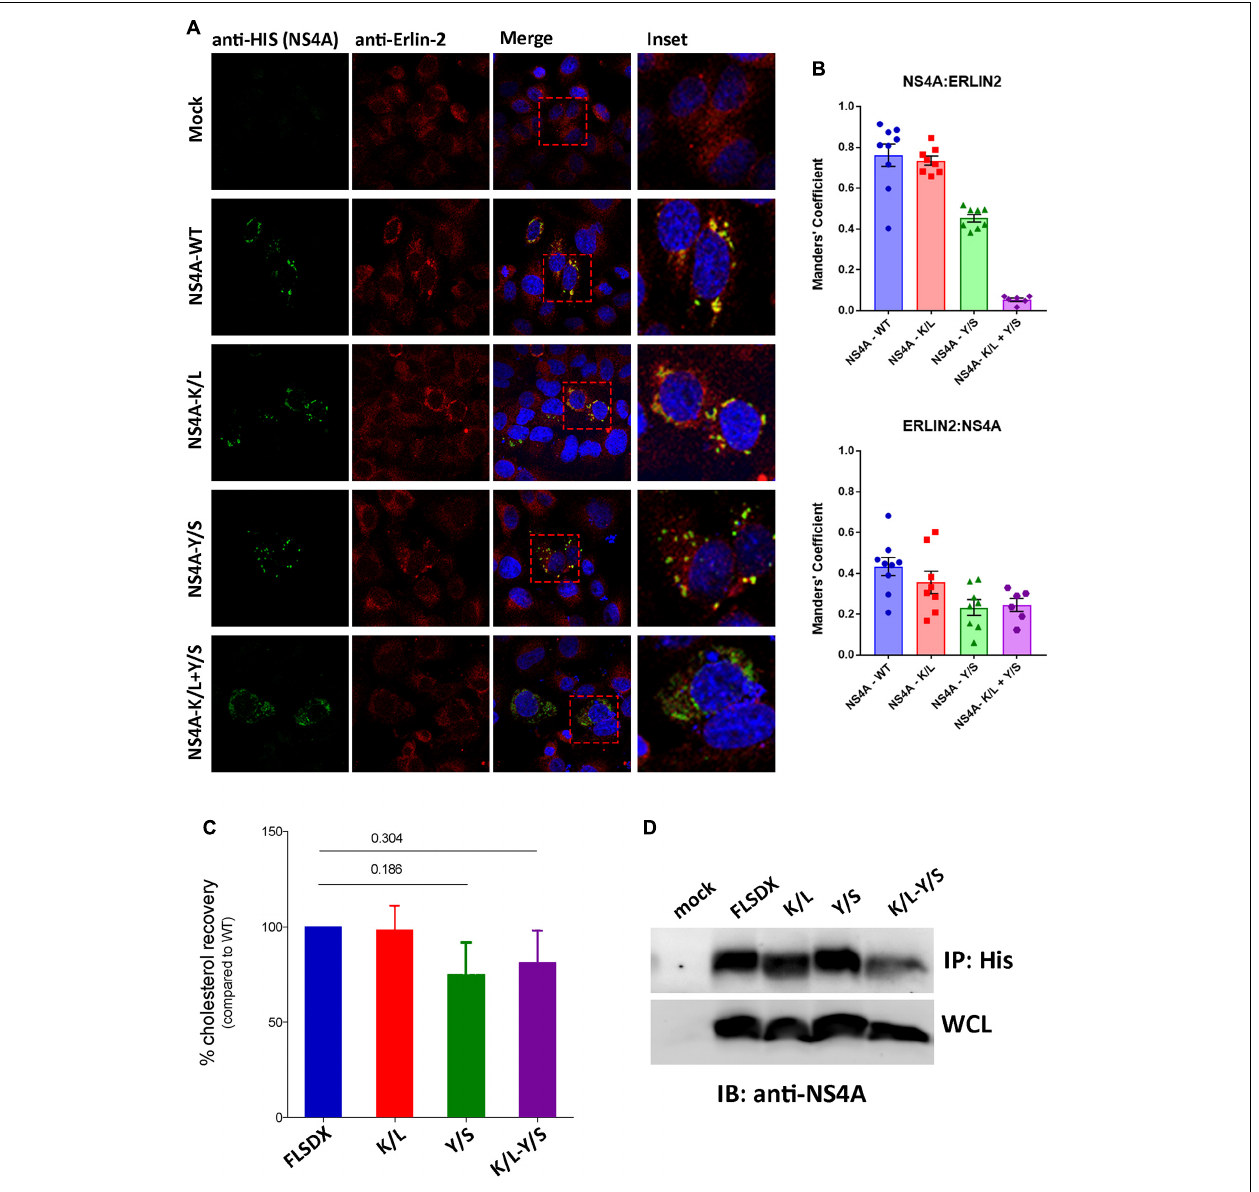
FIGURE 6 | The CRAC motif promotes colocation of NS4A with erlin-2 and a potential association with cellular cholesterol. (A) Vero cells transfected with recombinant NS4A-His plasmids for 24 h and subsequently immuno-stained with antibodies to 6xHis co-stained with Alexa Fluor 488 with antibodies to erlin-2 and co-stained with Alexa Fluor 594. Prominent co-localization between dsRNA and eGFP-erlin-2 proteins is observed as a yellow hue in the merge and insert panels on the right-hand side. (B) The extent of co-localization was assessed in Image J by evaluating the Manders’ coefficient of NS4A-erlin-2 and erlin-2-NS4A. (C) Percentage amount of cholesterol recovered from transfected cells after immune-precipitation with anti-His antibodies. Cholesterol recovery was measured via the Amplex Red cholesterol assay kit. Statistical significance was determined by Student’s t- test. (D) A representative western blot showing the expression level of the NS4A mutants in the input whole cell lysate (WCL) and their recovery after IP. Western blot was probed with anti-NS4A